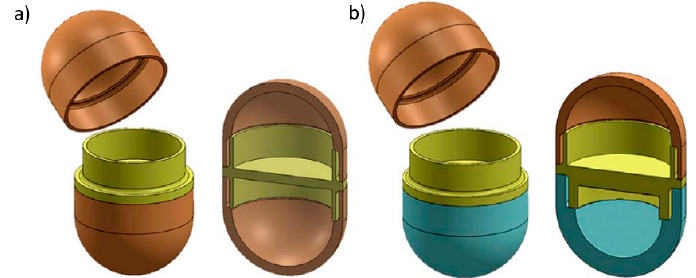
Figure 11. Two-compartment capsular device ( a ) compartments with the same wall thickness ( b ) compartments with different wall thickness (Reproduced with permission from reference [84], Elsevier, 2017).